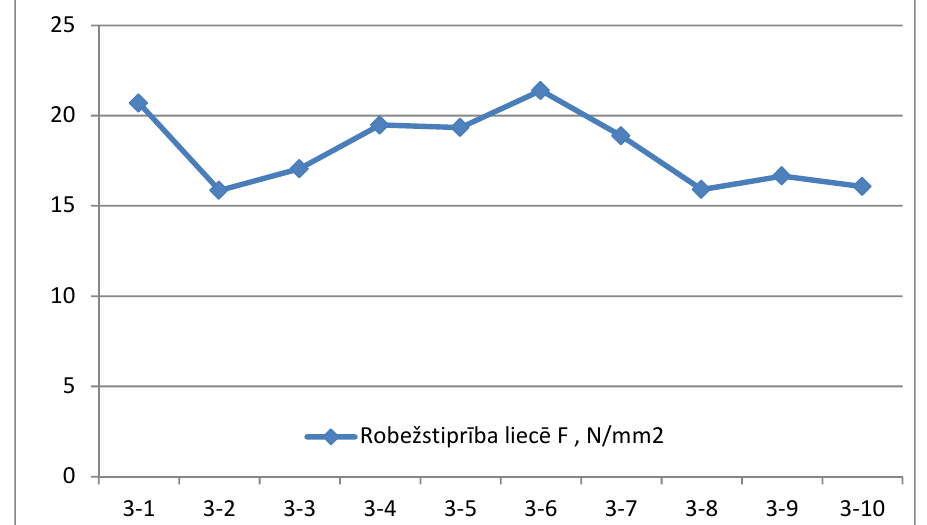
Figure 5. Borderline flexural strength N/mm 2 measurement graph for samples of group No. 3. The summary of the characteristics of samples made from the residues of glued timber structures (CLT panels) is shown in Table 4. Table 4. Summary of sample borderline flexural strength parameter (loaded on the narrowest face). Sample Label Maximum Load Pmax, N